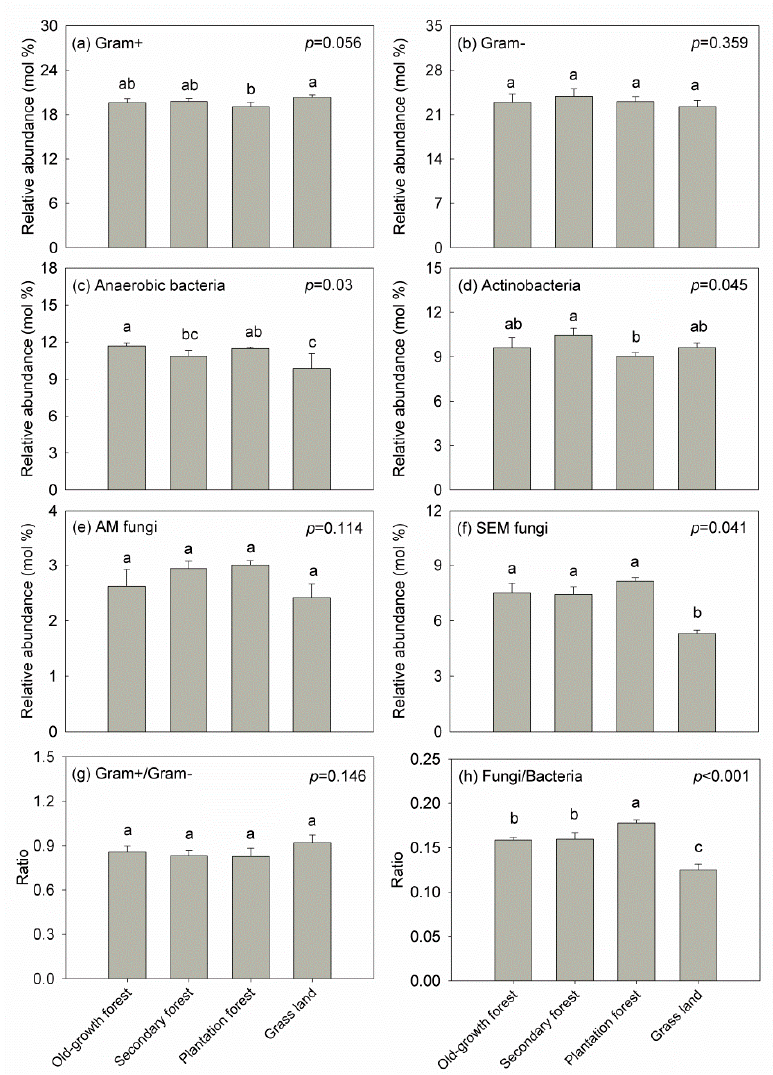
Figure 1. Relative abundance of di ff erent microbial group phospholipid fatty acids (PLFAs) in di ff erent land-use types. Error bars represent the standard error of the mean. Di ff erent letters indicate statistically significant di ff erences among the land-use types (Tukey’s HSD: p < 0.05).